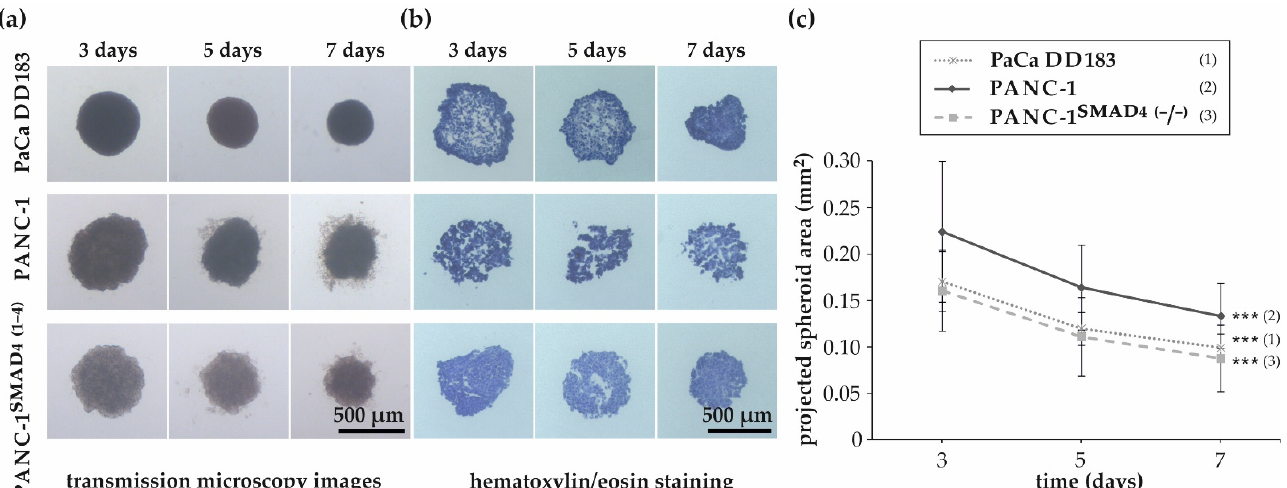
Figure 1. Generation of PDAC spheroids. Transmission microscopy images of spheroids ( a ) and cryosections of spheroids after hematoxylin/eosin staining ( b ) formed by PaCa DD183, PANC-1 and PANC-1 SMAD4 ( − / − ) cells after three, five and seven days of incubation. ( c ) Growth progression of spheroids between day 3 and 7. Data are expressed as the mean with standard deviation ( n = 4–5, with nine replicates each). Statistical significances between spheroid sizes at day 3 and day 7 are indicated with ***. The respective confidential intervals are p ≤ 0.00005 and were calculated via the Student’s t -test. Abbreviations: (1), PaCa DD183; (2), PANC-1; (3), PANC-1 SMAD4 ( − / − ) .